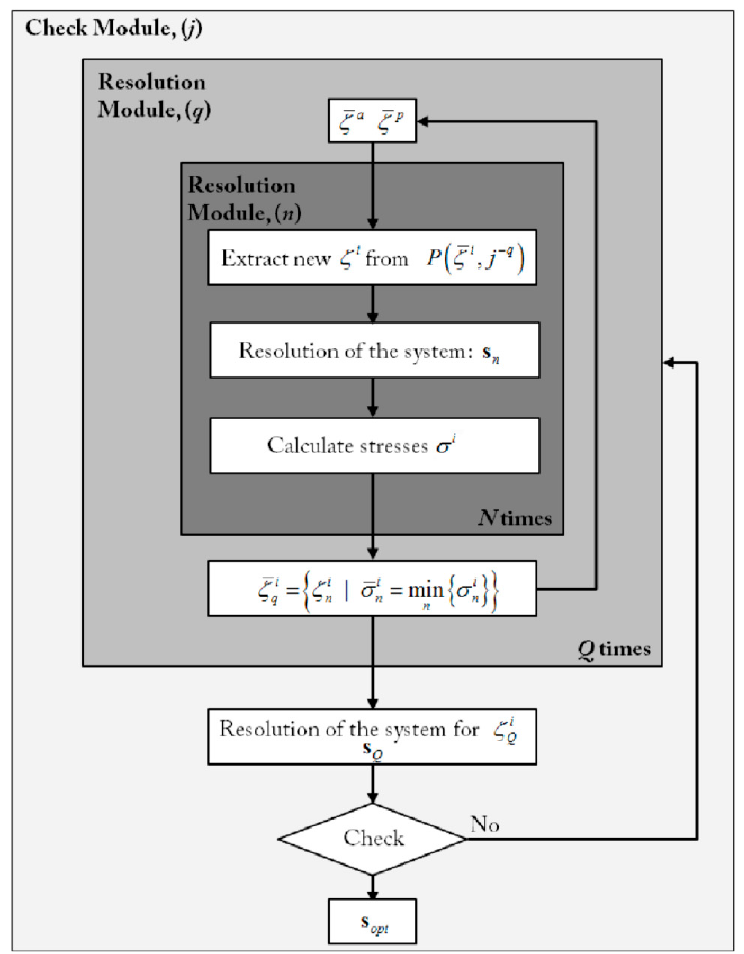
Figure 6. Conceptual scheme of the solution strategy. Starting from random search, the postoperative configuration is determined by adopting a minimum-stress criterion.